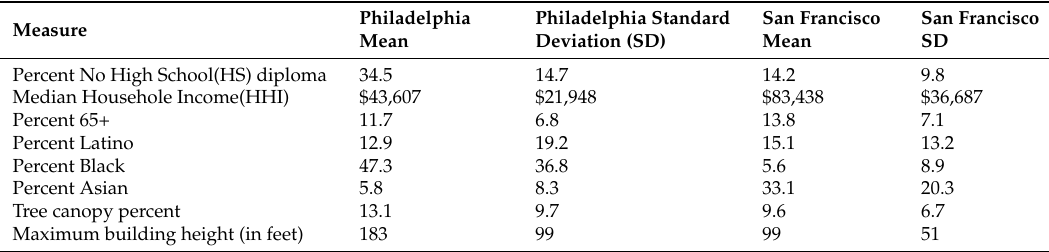
Table 2. Descriptive statistics of covariates.